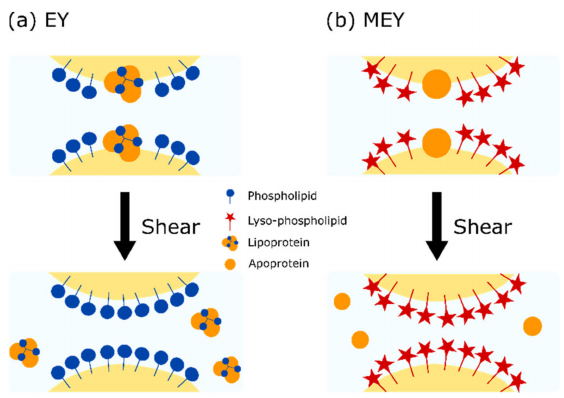
Figure 5. Schematic representation of the effect of enzymatic modification and shear treatment on surface composition of ( a ) EY and ( b ) MEY